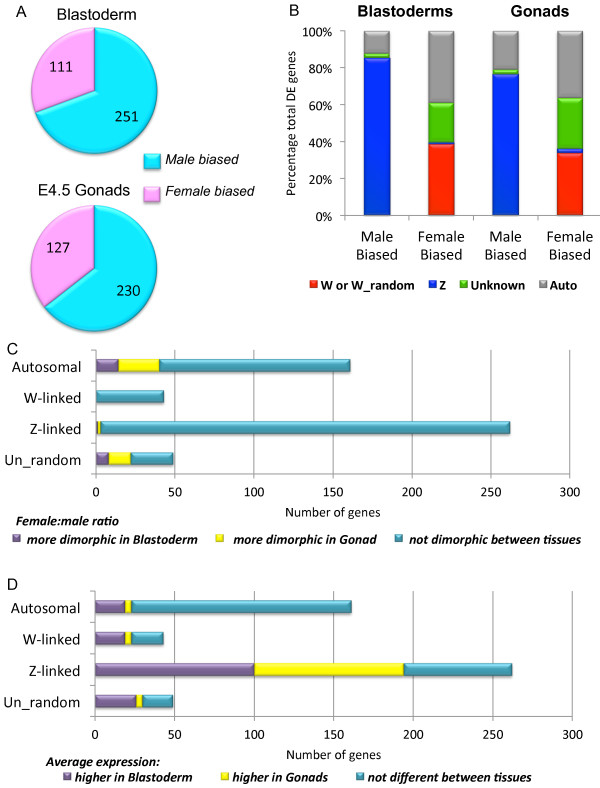
RNA-seq analysis of embryonic chicken blastoderms and embryonic day 4.5 (stage 26) gonads. (A) Differentially expressed annotated genes (Ensembl-based). Number of genes showing either male-biased differential expression (FDR <0.05; blue) or female-biased expression (FDR <0.05; red) in blastoderms and E4.5 gonads. (B) Chromosomal allocation of differentially expressed genes, based on annotated gene data. In blastoderms, female biased genes were located on the W or W_random chromosome (red), the autosomes (grey), or the un-assembled Un_random chromosomes (green). One Z-linked gene showed female-biased expression (aqua). The vast majority of male-biased genes were Z-linked (aqua), and autosomal (grey). Two were on Un_random chromosomes and zero on the W chromosome. A similar pattern was observed in the gonads, with the majority being Z-linked in males, and W-linked or on the Un_random in females. (C) Bar graph illustrating the number of genes with sexually dimorphic expression in at least one tissue on the W, Z, autosomal and Un_random chromosomes. Genes were tested for different patterns of sexually dimorphic expression between tissues, and are grouped as to whether they show a significantly larger female: male ratio difference in the blastoderms (purple), the gonads (yellow) or whether no significant difference is observed (aqua) (FDR <0.05) (See also Additional file 4, Table S1c). (D) Bar graph of genes of genes that are significantly sexually dimorphic in at least one tissue on the W, Z, autosomal and Un_random chromosomes, similar to Fig. 1C). Here, genes are grouped based on a change in average expression between tissues. Shown are the number of genes which are significantly more highly expressed in the blastoderms (purple), higher in the gonads (yellow), and no significant change (blue) (FDR <0.05) (See also Additional file 4, Table S1c).